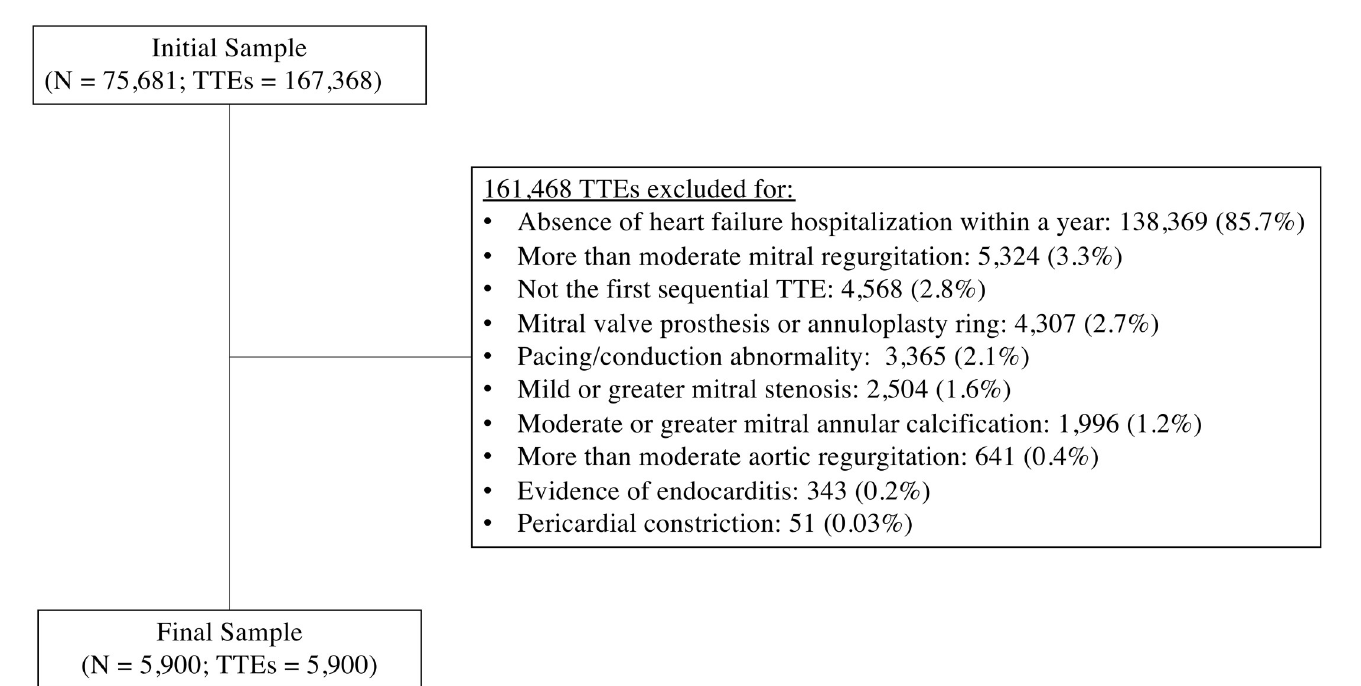
PLOS ONE | https://doi.org/10.1371/journal.pone.0244379 December22,